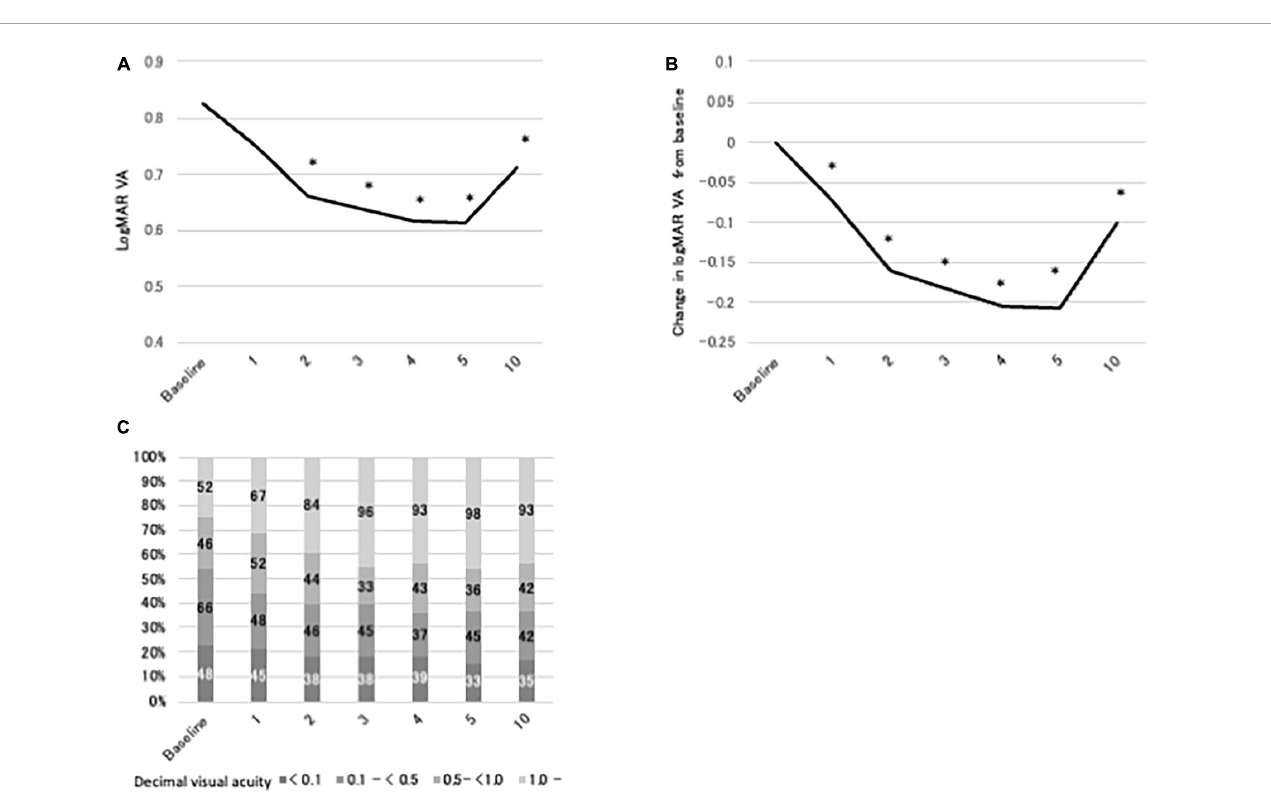
FIGURE2 (A) Mean logMAR VA at baseline and at 1, 2, 3, 4, 5, and 10 years after initiation of infliximab treatment in all BD patients ( n = 94). ∗ P < 0.05 versus baseline by Steel’s multiple comparison test. (B) Mean change in logMAR VA from baseline at 1, 2, 3, 4, 5, and 10 years. ∗ P < 0.05 versus baseline by Steel’s multiple comparison test. (C) Bar graph of proportions of eyes with different categories of VA at baseline and at 1, 2, 3, 4, 5, and 10 years. Chi square test indicated P =